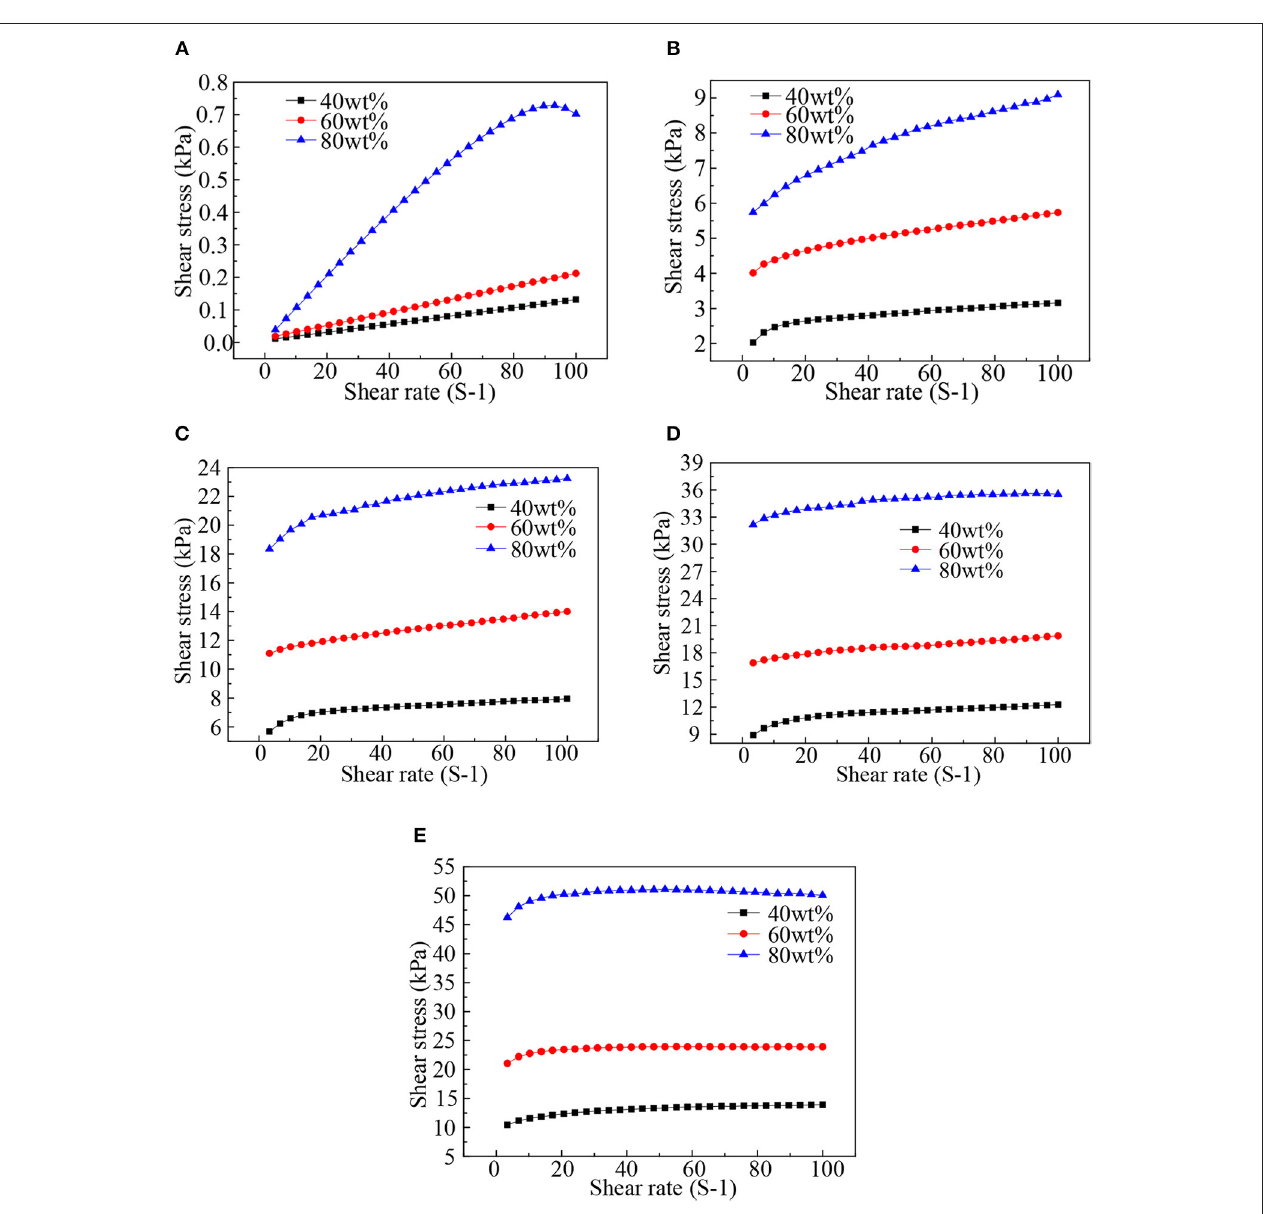
FIGURE 4 | Shear stress vs. shear rate under different magnetic flux densities ( A : B = 0 mT; B : B = 240 mT; C : B = 480 mT; D : B = 720 mT; E : B = 960